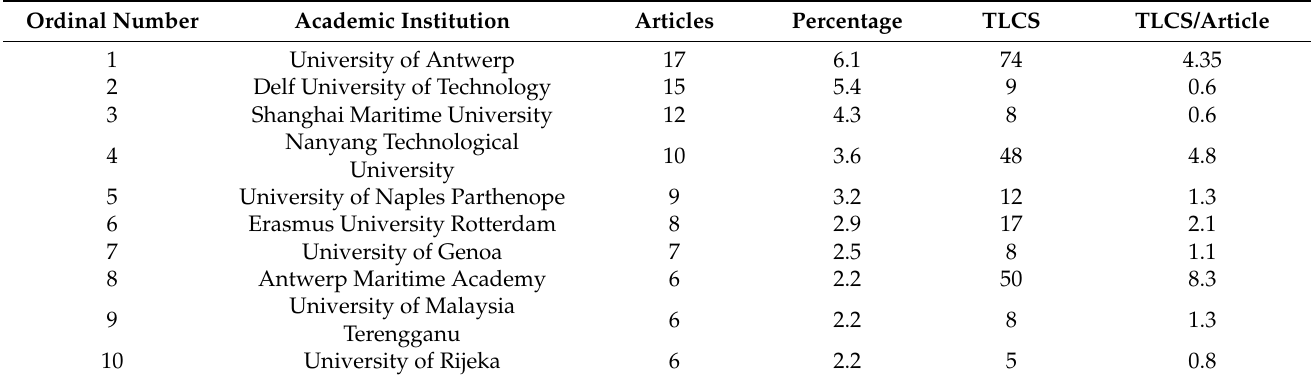
Table 2. The top 10 prestigious academic institutions regarding the emerging green port research